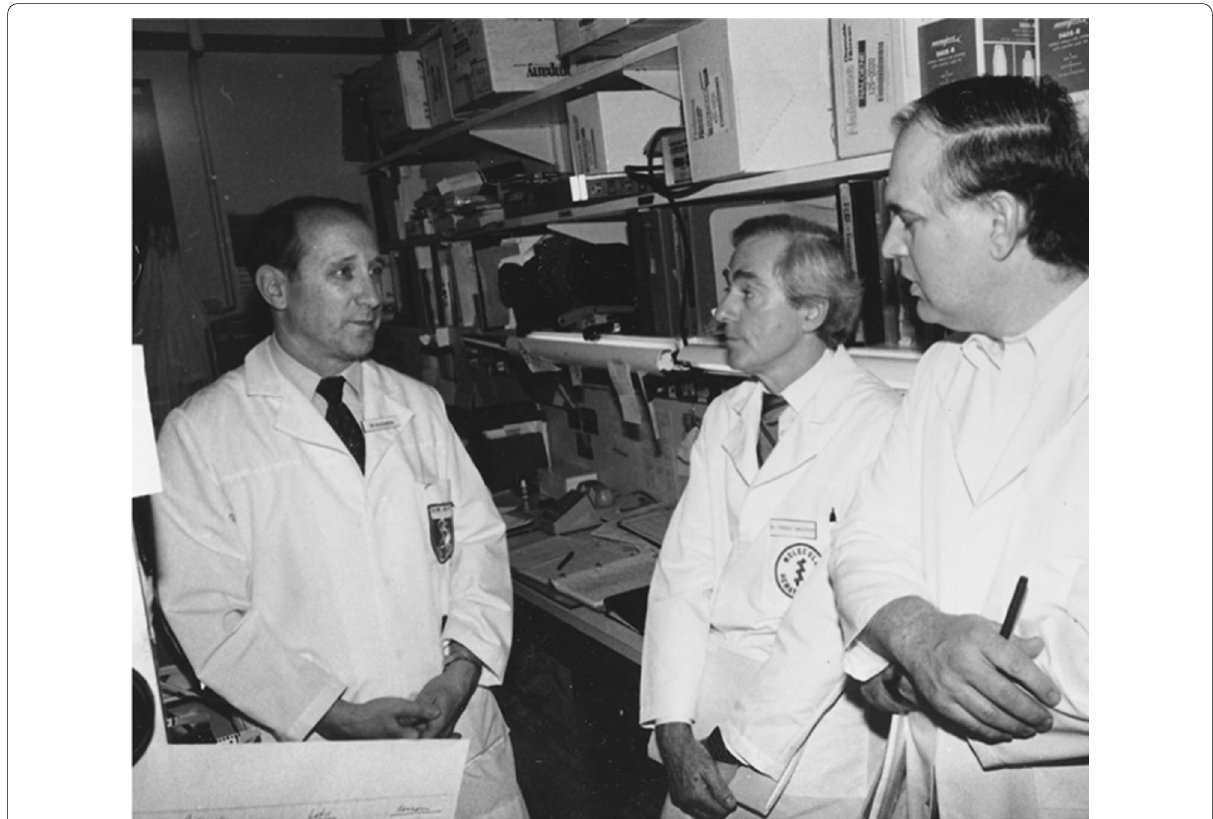
Fig. 3 One of many discussions I had with W. French Andersen and Michael Blaese in 1989 as we planned and conducted the first introduction of a foreign gene into